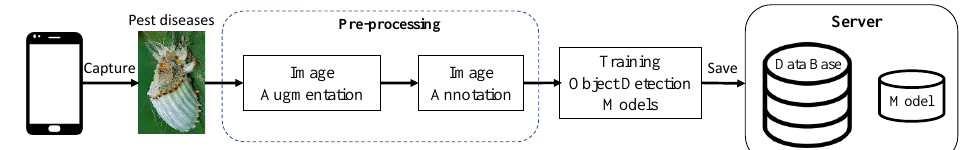
Figure 2. The training process of an AI-based pest detection system.